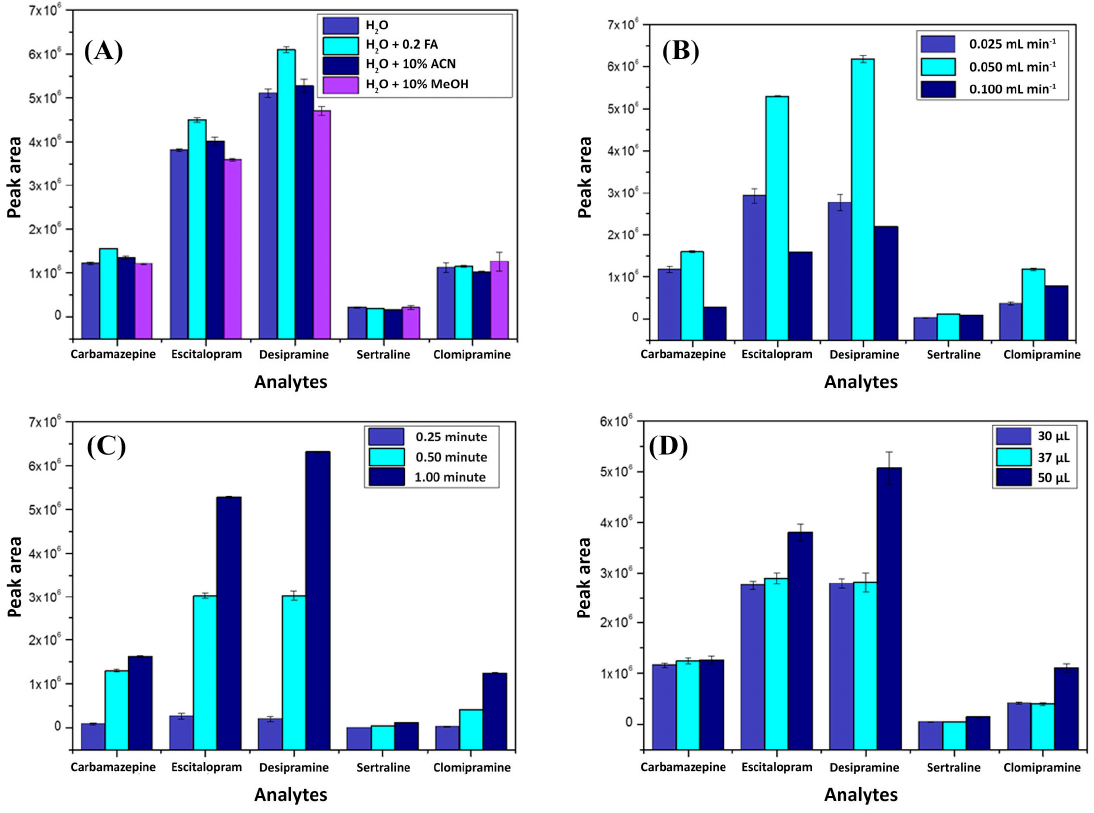
Figure 2. Method enhancement parameters obtained by univariate experiments considering the following parameters: ( A ) loading phase, ( B ) loading flow, ( C ) loading time, and ( D ) injection volume.